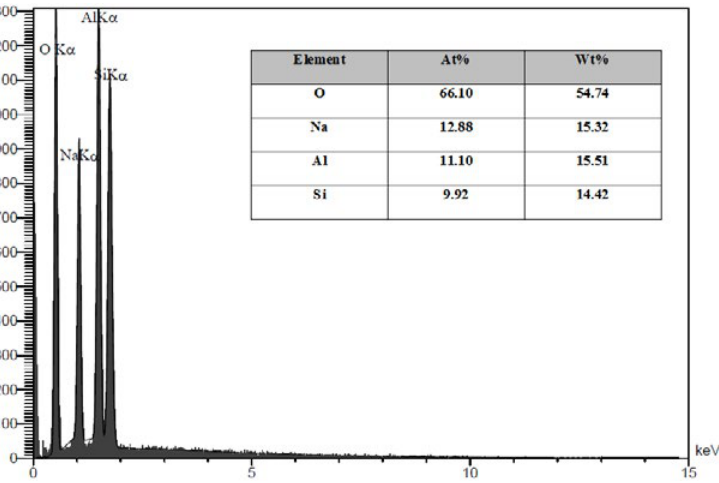
Fig. 5: The EDS analysis of the sample synthesized at 98 o C, 72 h. Fig. 5. The EDS analysis of the sample synthesized at 98 o C, 72 h.